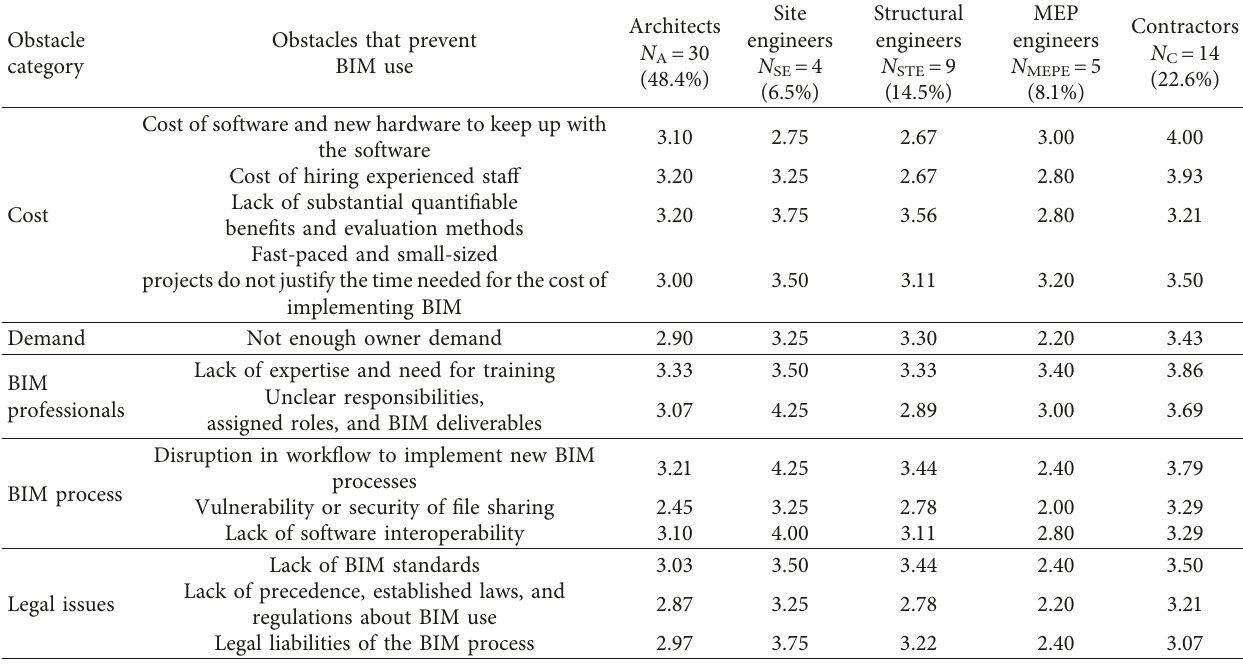
Table 11: Relationship between the role of the respondent and their perception of the obstacles preventing the use of BIM (mean/average rating score).